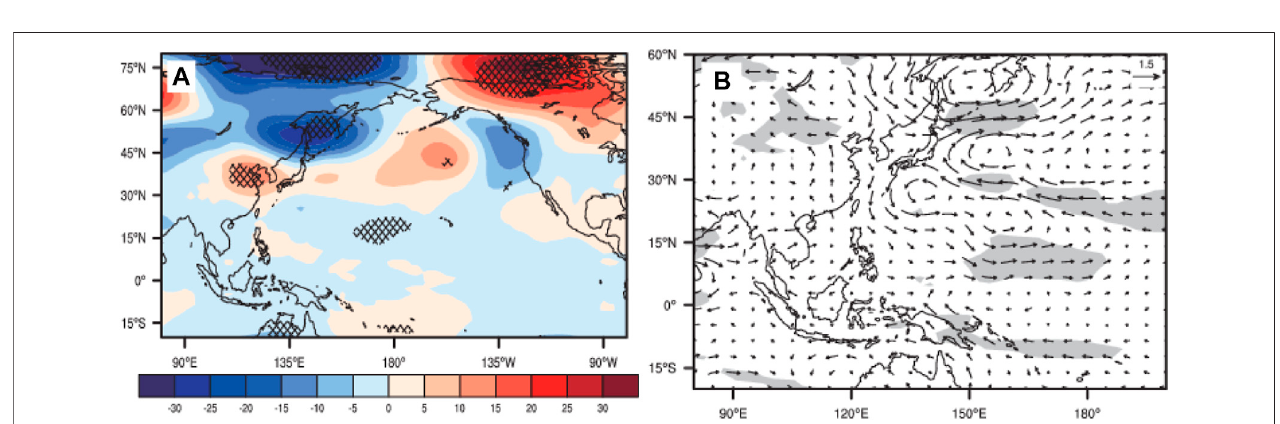
FIGURE 14 | Ensemble-mean differences of (A) 500 hPa geopotential height (gpm), (B) 850 hPa wind (m/s) anomalies in July – September between Niño3-C and Niño3-W. (A) Dotted areas and (B) shaded areas indicate the differences that are signi fi cant at the 90% con fi dence level.